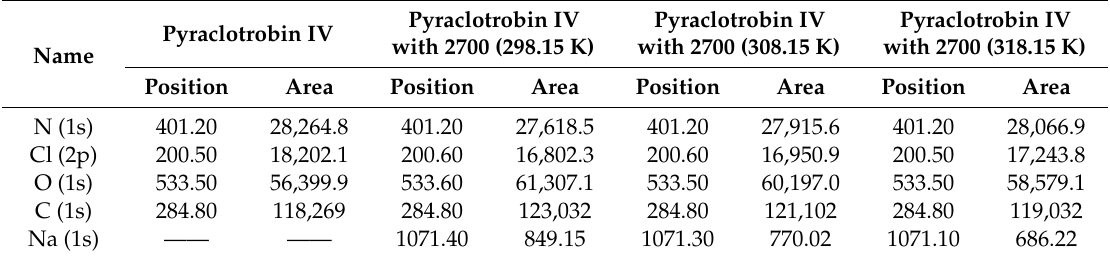
Table 5. Electron bonding energy and concentration of each element in pyraclostrobin crystal IV with adsorbed 2700.